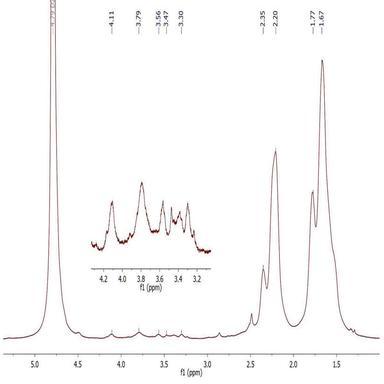
1 H NMR spectrum of HC-g-Am-BIS-BT (200 MHz, D2O).